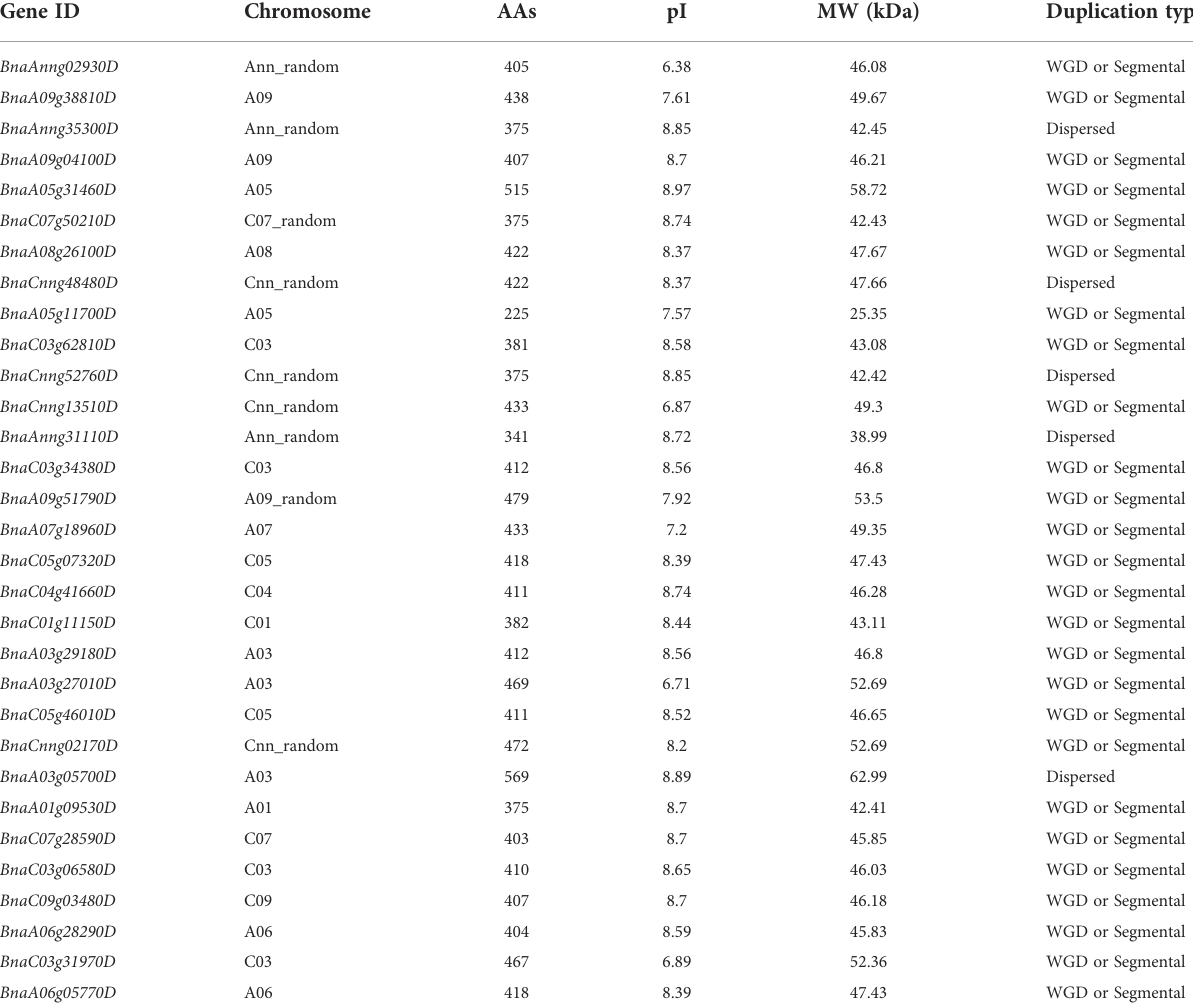
TABLE 3 The information of BnGSK3s family in